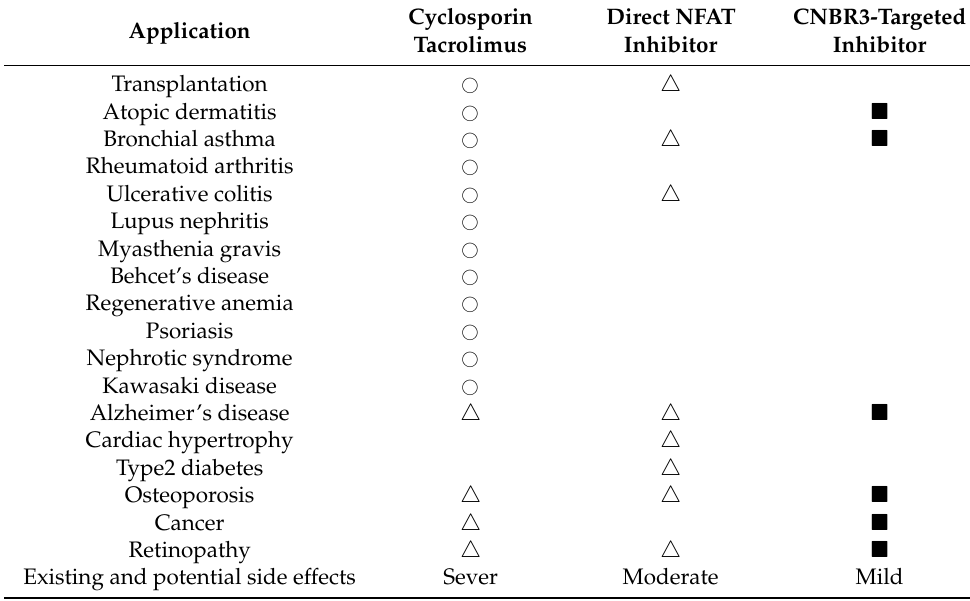
Table 3. Current and potential application of NFAT